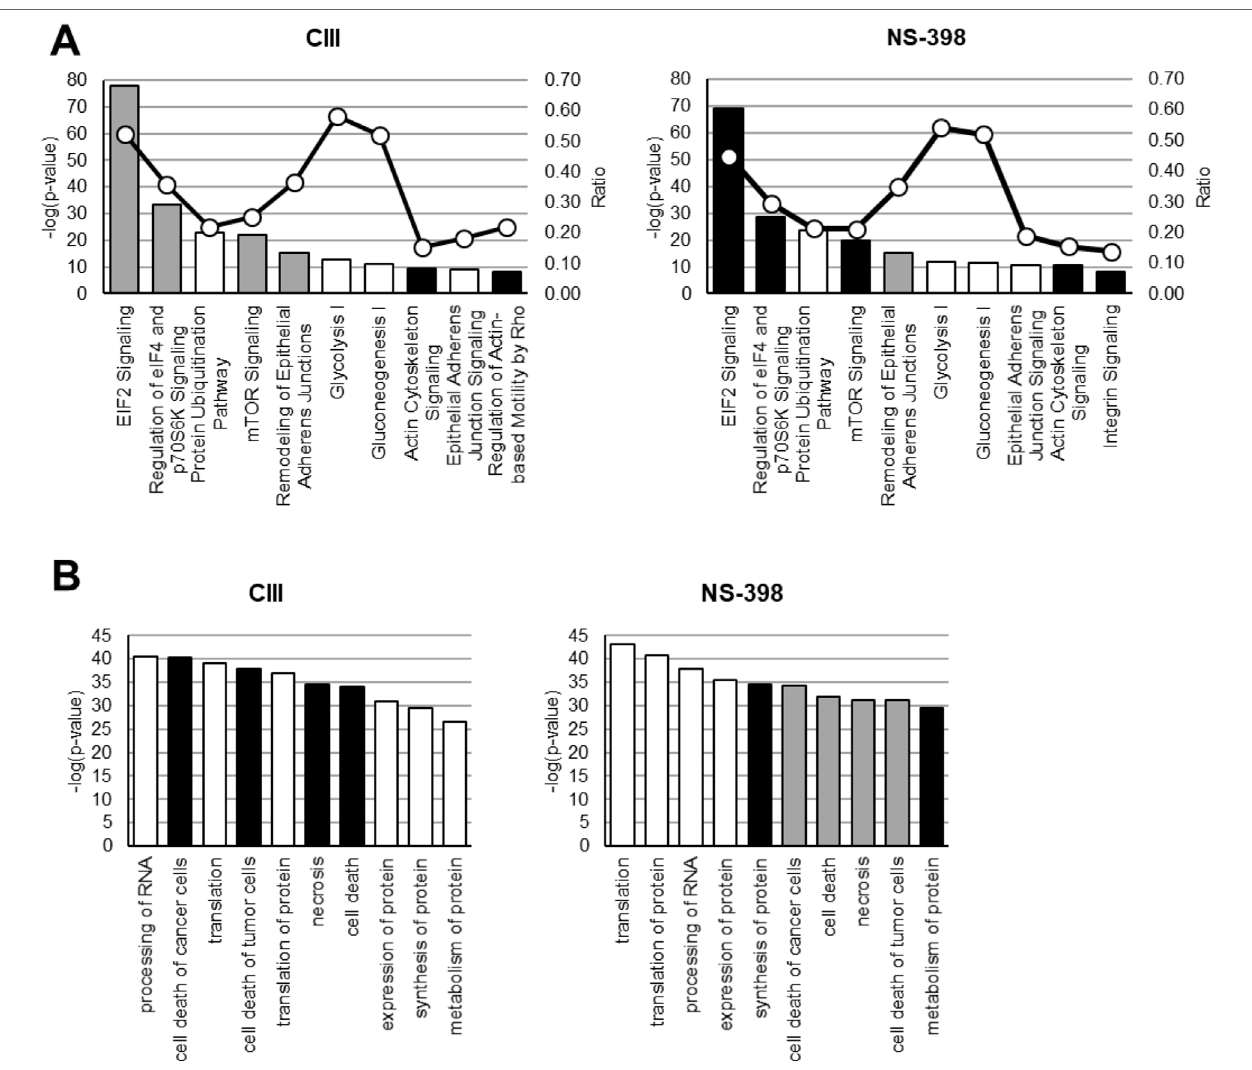
FIGURE 2 | Effect on molecular functions by CIII and NS-398. IPA was performed on quantified proteins from CIII and NS-398 samples. (A) The top 10 affected canonical pathways based on p value are shown for each inhibitor. The calculated Z score indicates a pathway with proteins exhibiting overall increased levels ( Z > 0, black bars) or decreased levels ( Z < 0, gray bars). White bars represent no overall increase or decrease of proteins in the assigned pathway. The ratio (white dots connected by a black line) shows the fraction of proteins from the dataset that map to the pathway compared to the total number of proteins that map to the same pathway in the database. (B) The top 10 affected disease and function annotations for each inhibitor based on p value are shown. The different bar colors represent if a function is predicted to be increased in activation ( Z > 2.0, black bars) or decreased in activation ( Z < −2.0, gray bars). White bars represent change in function but the direction was not predicted. Z scores are presented in Results